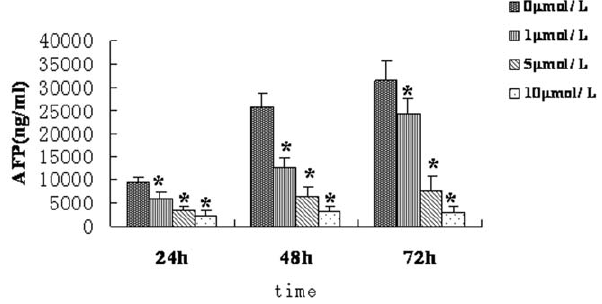
Figure 3. Effect of As2O3 on AFP concentrations in cell culture supernatant of FU97 cells. As 2 O 3 decreased AFP protein level concentration dependently. Data are representative of 3 independent experiments with similar results. *p , 0.05 compared with 0 m